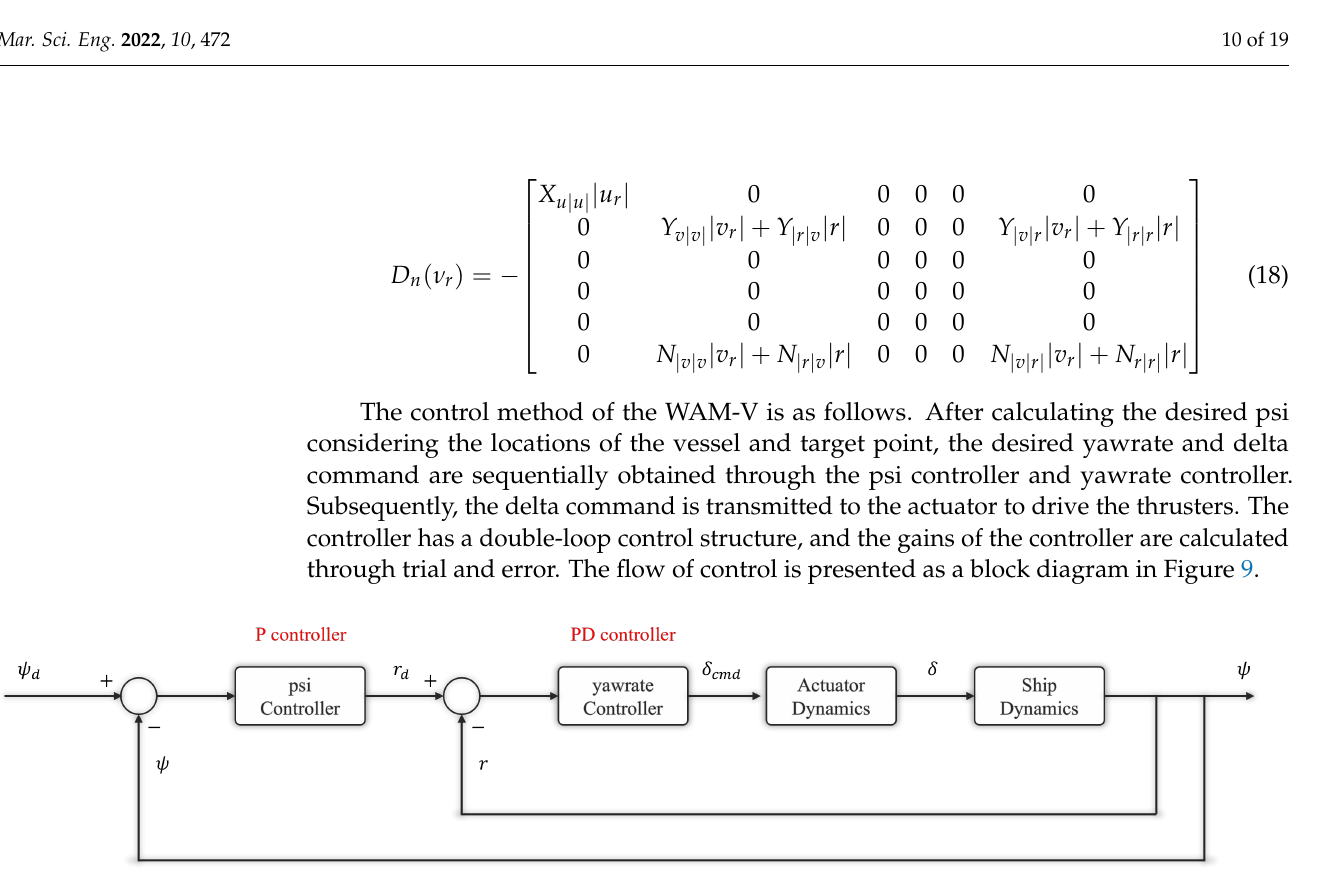
Figure 9. Process flow of ship actuator control.